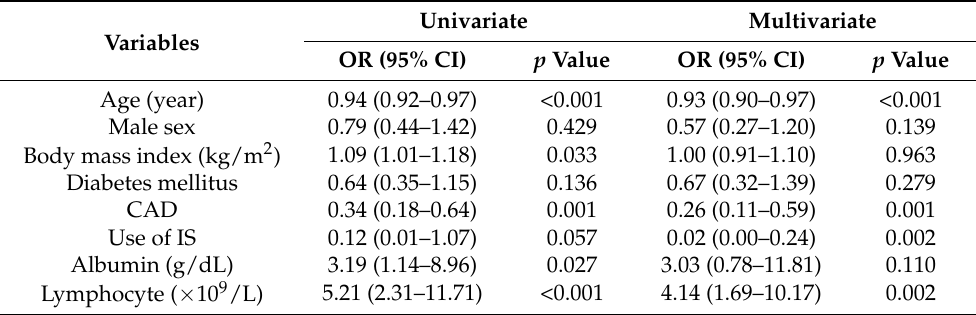
Table 3. Baseline characteristics as determinants of the anti-spike IgG antibody response to SARS- CoV-2 vaccination.